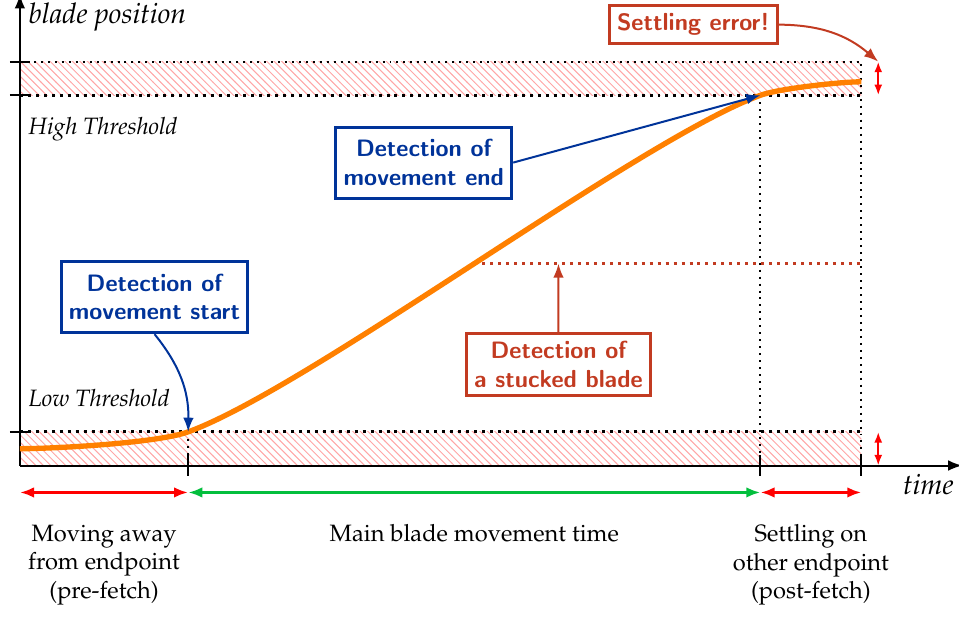
Figure 9. Displacements of switch’s point